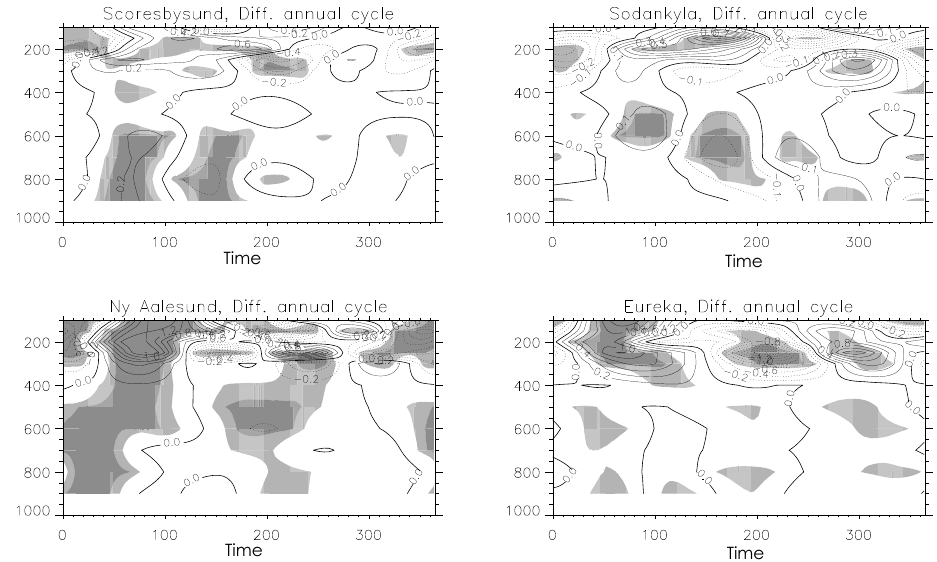
Figure 11. Difference between average annual cycles over 2007–2012 and 1995–2000 (i.e. average over 1995–2000 subtracted from average over 2007–2012) as a function of pressure level. Shaded regions are where the anomalies are statistically different from the temporal means at 99 and 95% levels. Model settings: n pol = 4, n cyc = 3, n a tr = n θ tr = 2, and white